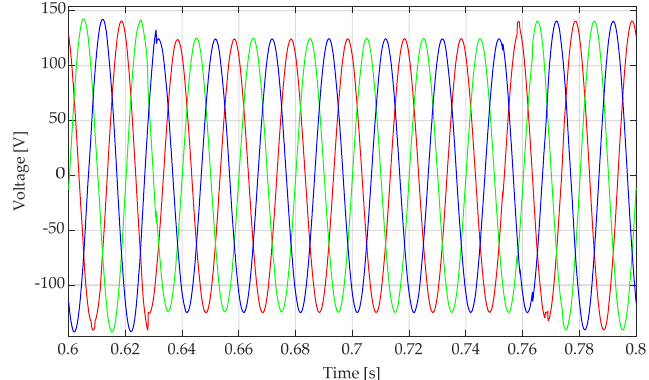
Figure 7. Line ‐ to ‐ line voltage waveform: typical dip due to VT saturation . For these reasons, from a theoretical point of view, the “false dip” can occur in IN systems and not in CN